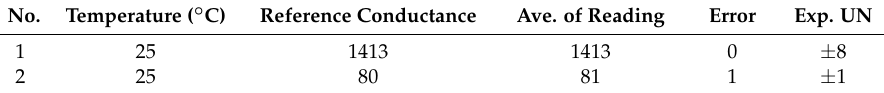
Table 1. Values obtained from calibration of cond.meter with reference